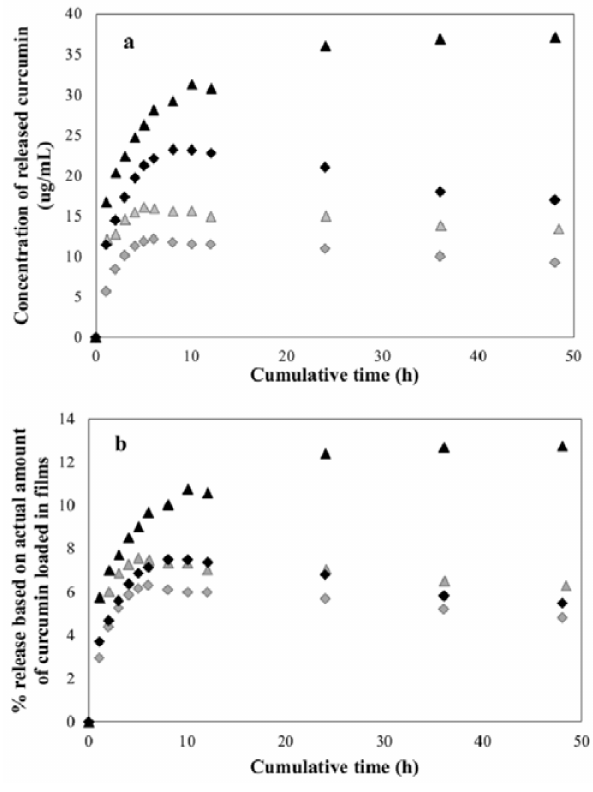
Figure 5. Release profiles of curcumin from BCC0.5 (gray) and BCC1.0 (black) into buffer solutions (acetate buffer at pH 5.5 ( (cid:78) , (cid:78) ); PBS at pH 7.4 ( (cid:7) , (cid:7) )) supplemented with Tween80/methanol: ( a ) concentration of released curcumin and ( b ) percentage of release based on actual amount of curcumin loaded in BCC